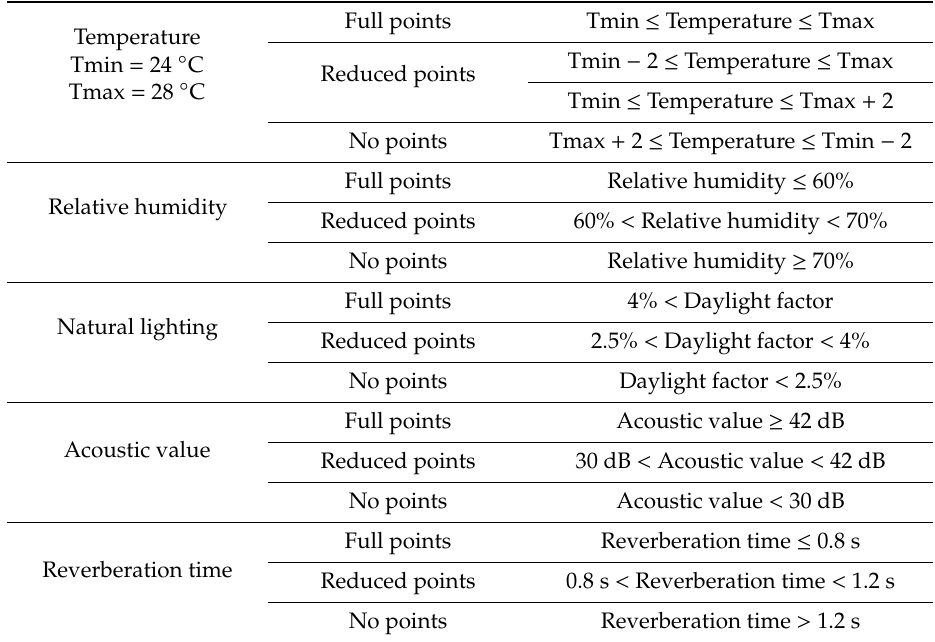
Table 3. Comfort test subcategory score range in SDLAC